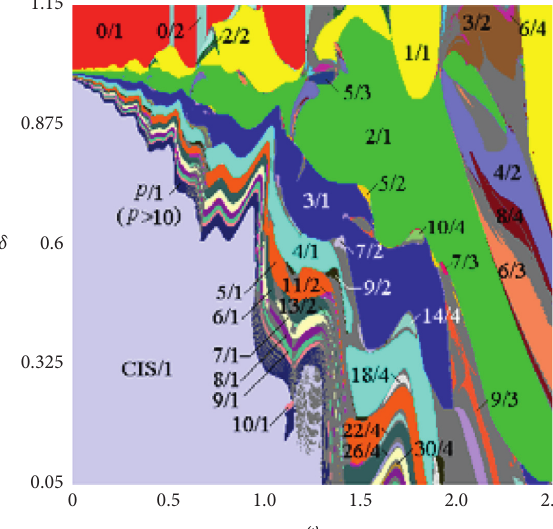
Figure 26: Periodic motions on the ( ω , δ ) -parameter plane associated with each constraint when ζ � 0.05. (a) Constraint A A 12 ; (c) constraint A 2 .